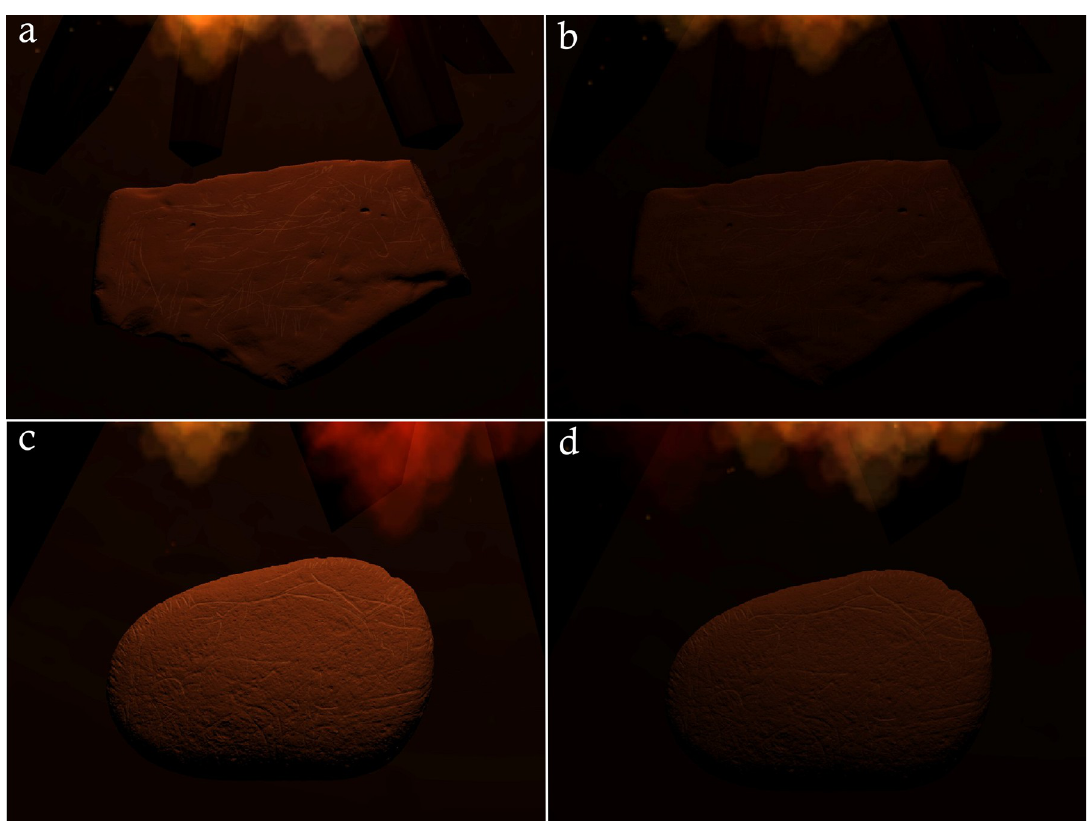
Fig 6. High resolution screen captures of the 3D models of plaquette 691 (a, b) and plaquette 684 (c, d) from Montastruc in the VR simulation at the maximum and minimum illumination as the light flickered. For both plaquettes, aspects become more or less visible as the light shifts, adding to a sense of